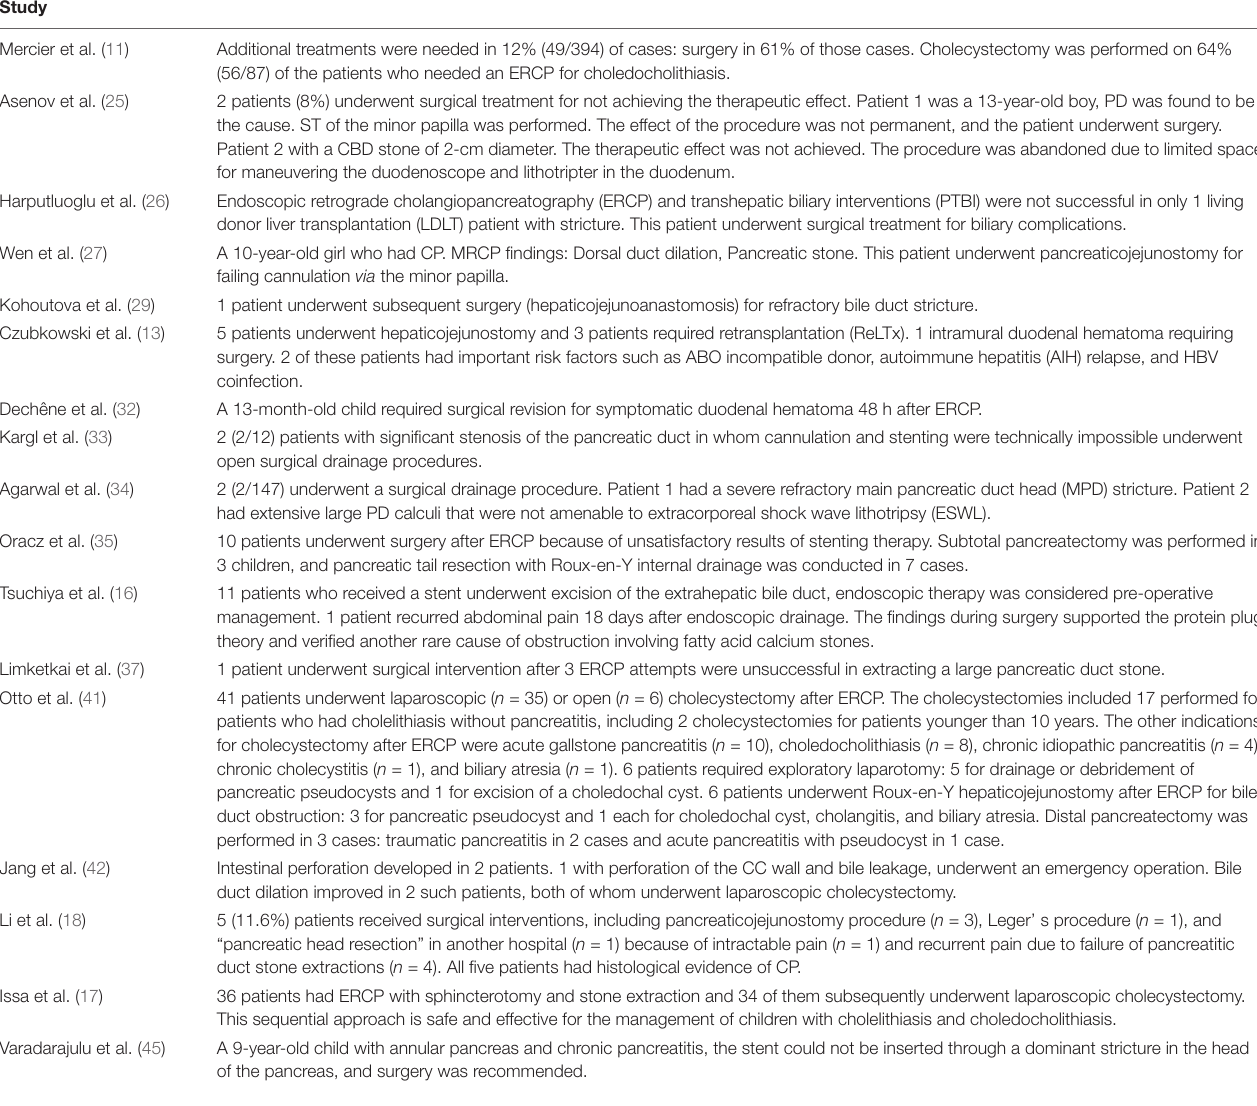
TABLE 5 | Cases required surgical interventions after therapeutic endoscopic retrograde cholangiopancreatography